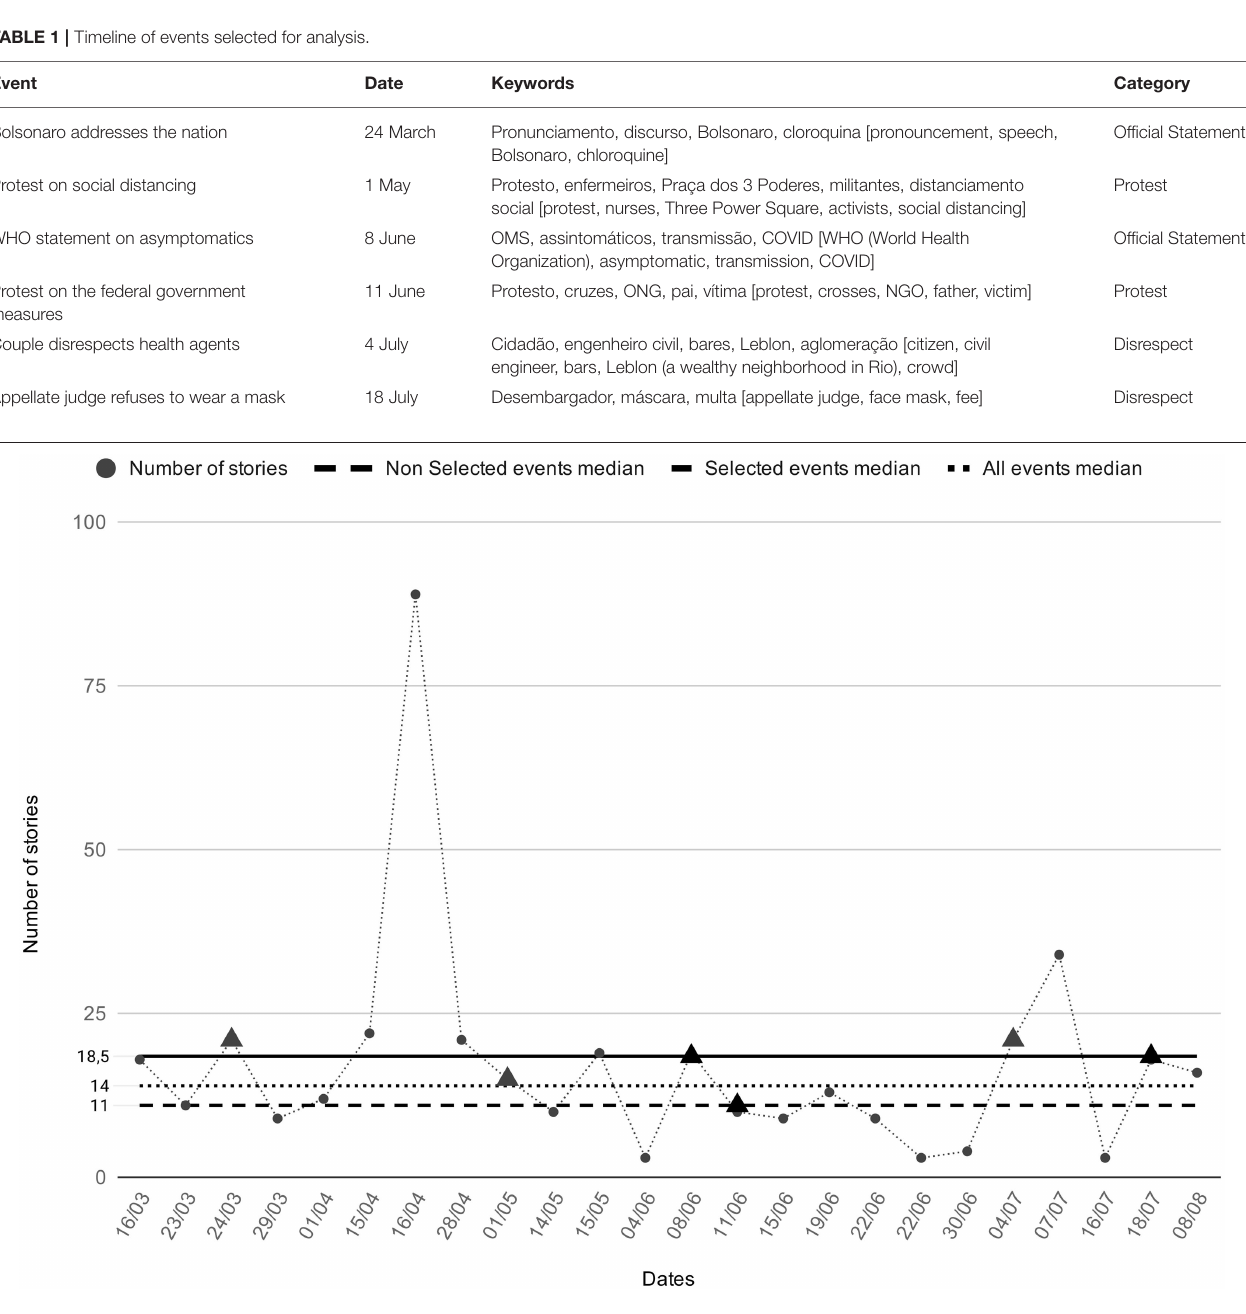
FIGURE 1 | Media references to 24 key events regarding the pandemic in Folha de São Paulo, O Globo , and O Estado de São Paulo , March–August 2020. Overall median is 14 stories; median for stories about six selected events (marked with triangles) is 18.5, median for all other stories is 11.5.